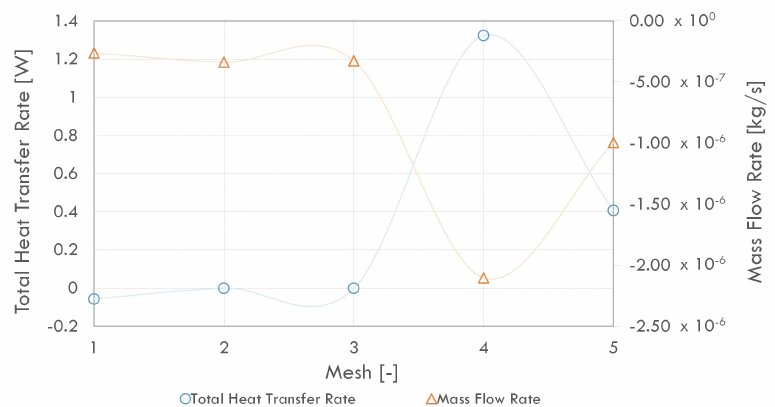
Figure 10. Effect of the grid on the balance of streams. Determination of the balance of individual rates for each grid allows, as it were, to confirm the fact that for grids 4 and 5, the greatest loss in mass and heat flow is observed. Hence, to obtain a correct numerical solution, it was decided to choose grid 3 (Figure 11). It is also a trade-off between the number of mesh elements and the accuracy of the solution.